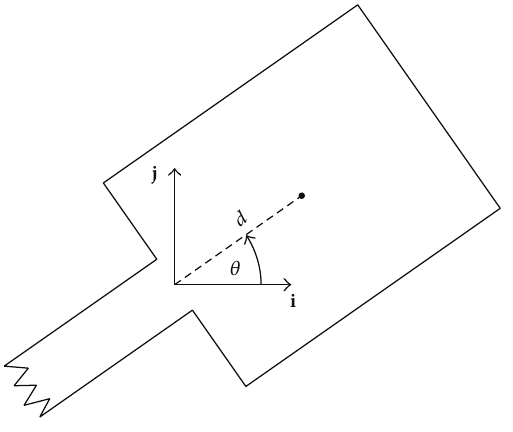
Figure 1: The tip body at the end of the